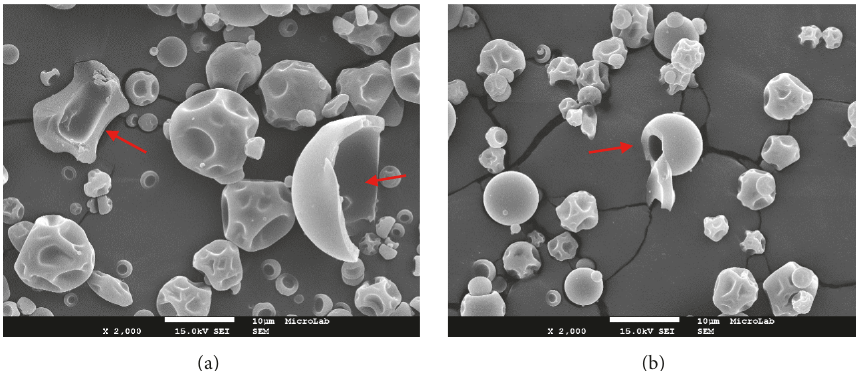
Figure 2: Scanning electron microscopy (SEM) images (magnification x2000) of the internal surface of Arabic gum microparticles with 𝛽 -carotene microencapsulated. (a) 20 %AG, 110 ∘ C; (b) 9.4 %AG, 123.2 ∘